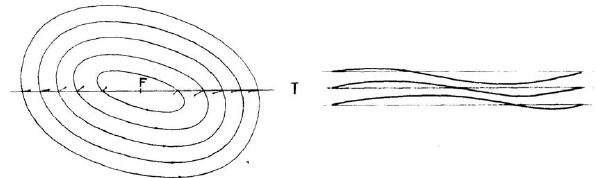
Fig. 1. Taken from Mayaud (1965), the flow lines for a tilted cur- Fig 1. Taken from Mayaud (1965), the flow lines for a tilted current system in the northern hemisphere are shown on the left with associated magnetic field directions given by arrows along a line passing rent system in the Northern Hemisphere are shown on the left with through the focus F. On the right is a schematic of the daytime variation of the magnetic field H or X at associated magnetic field directions given by arrows along a line a station just north of the focus, at the focus and just south of it. passing through the focus F . On the right is a schematic of the day- An examination of Fig 1 reveals several features which may point to a tilted current time variation of the magnetic field H or X at a station just north of whorl: 1. Zero Δ H occurs when the magnetic field direction is exactly eastward or the focus, at the focus and just south of it. westward. The latitude where this happens is towards the south at places east of the focus and towards the north at places west of the focus. 2. The maximum of the Δ H curve occurs later in time as we go from north to south of the focus. This can be seen in the right hand diagram of Fig 1. Similarly the time of minimum of Δ H occurs later in the south. 3. The Time of zero crossing of the Δ H curve likewise becomes later as we go from north to south of the focus. 4. Similarly the eastward magnetic variation Δ Y goes through zero later at latitudes south of the focus than north of the focus.